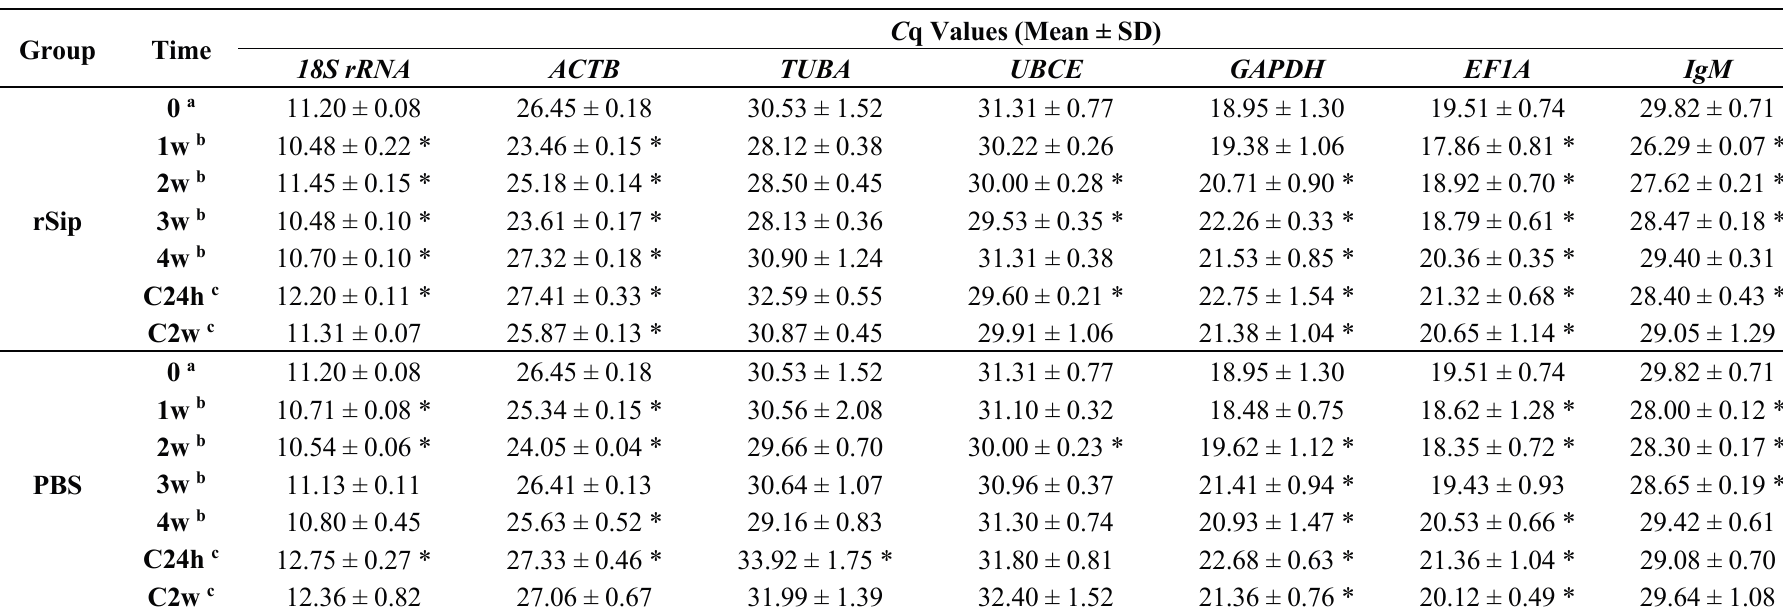
C q Values (Mean ± SD)